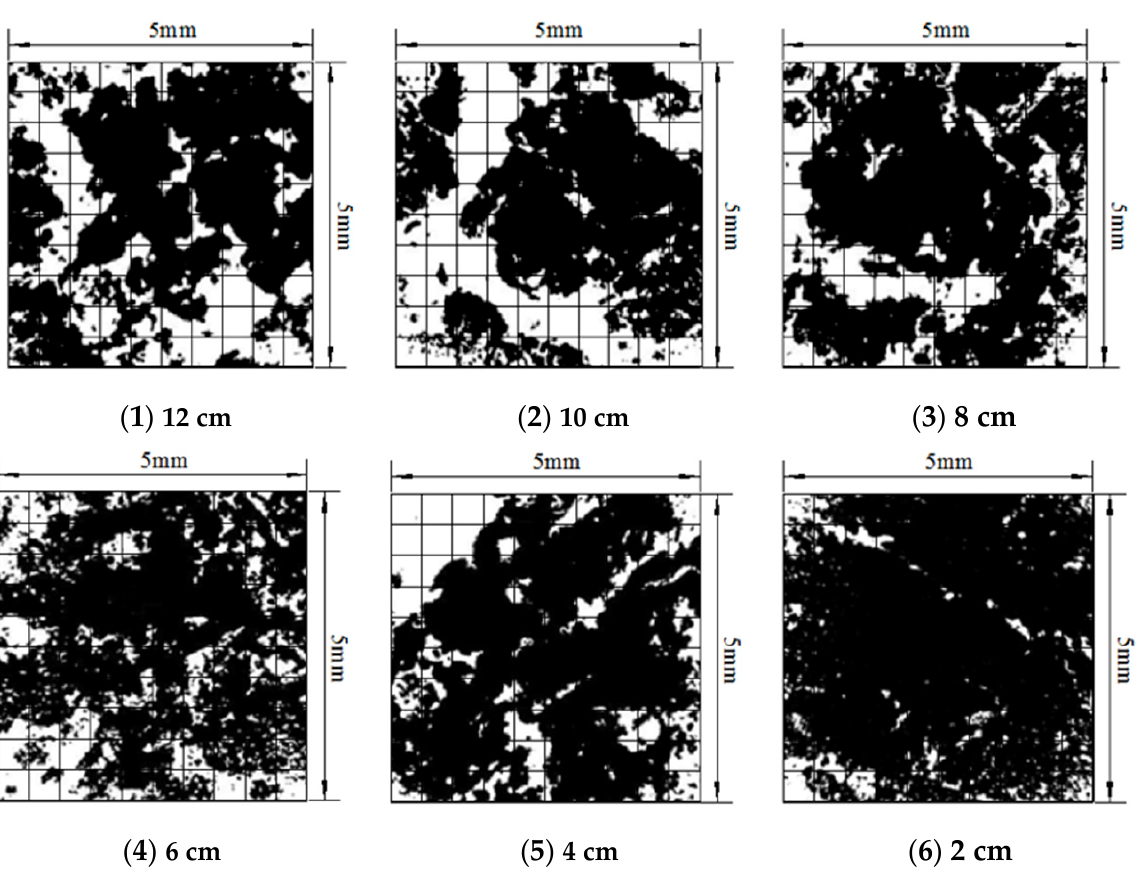
Figure 7. Binarization of bed seepage channel distribution images and box dimension calculation.